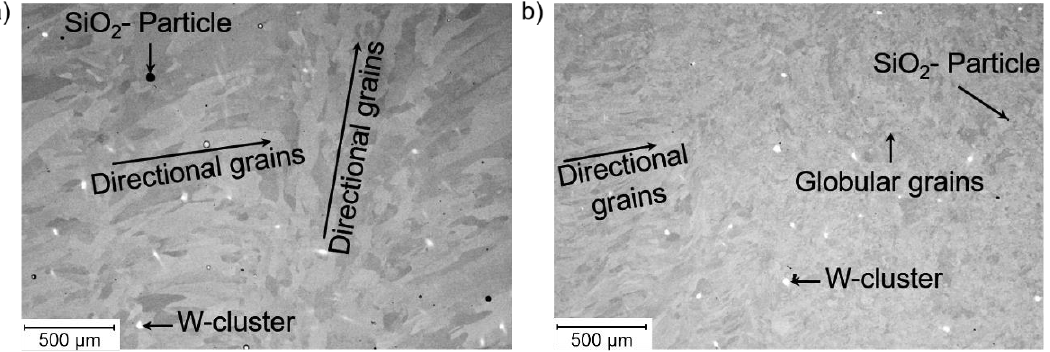
Figure 7. SEM micrographs of LMD-manufactured HiperFer AM in the as-built state: ( a ) LPD and ( b ) HPD variants.